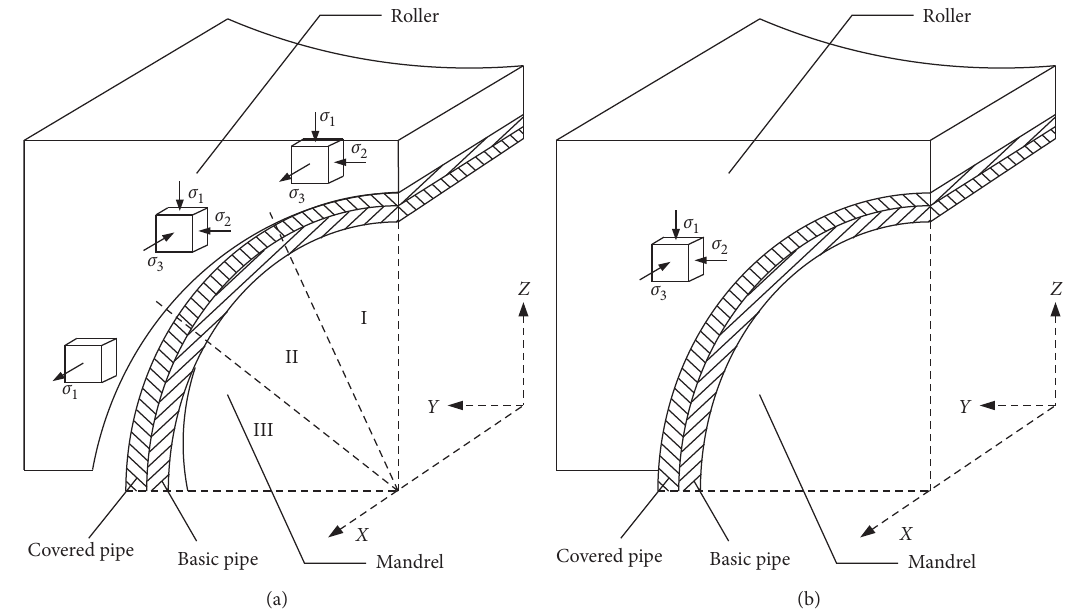
Figure 4: The stress state in deformation zone and finishing zone of pilger hot rolling bimetal clad tube. (a) Deformation zone. (b) Finishing zone.